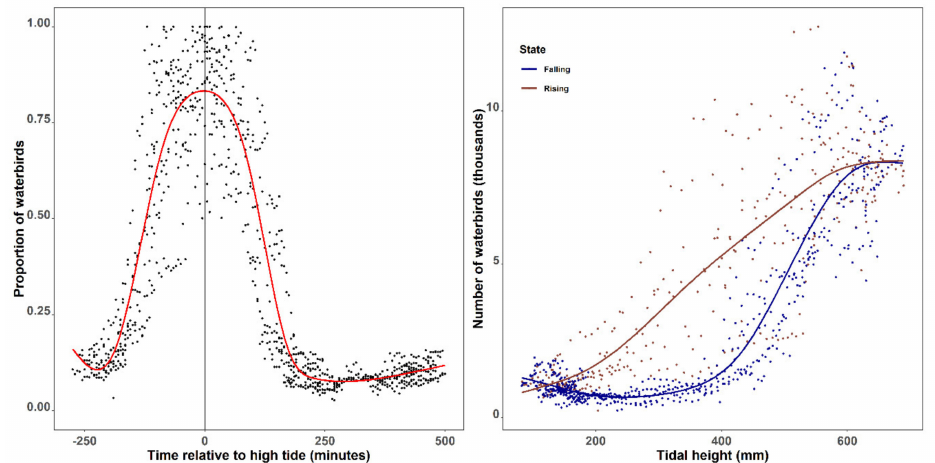
Figure 9. The relationship between waterbird abundance at the roosting site and tide height based on estimations from 984 images extracted from surveillance video data collected for the peak autumn migratory season (9 August and 1 October). Dots are estimated abundance dashed and lines are gam smoothed curve. Left panel shows the variation of waterbird abundance (percentage to the total count) at the roosting site during a tidal cycle. Right panel illustrates the relationship of the number of waterbirds at the roosting site and tidal heights during periods of rising (dark brown) and falling (dark blue)